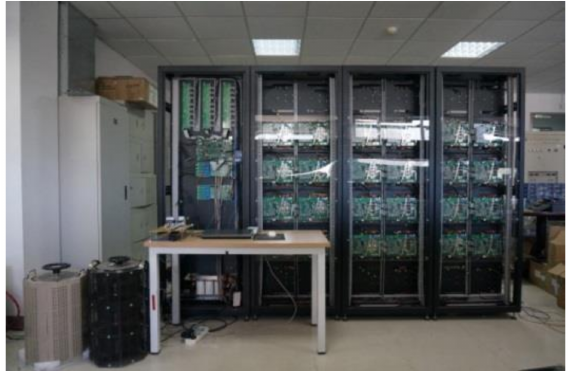
Figure 14. The prototype